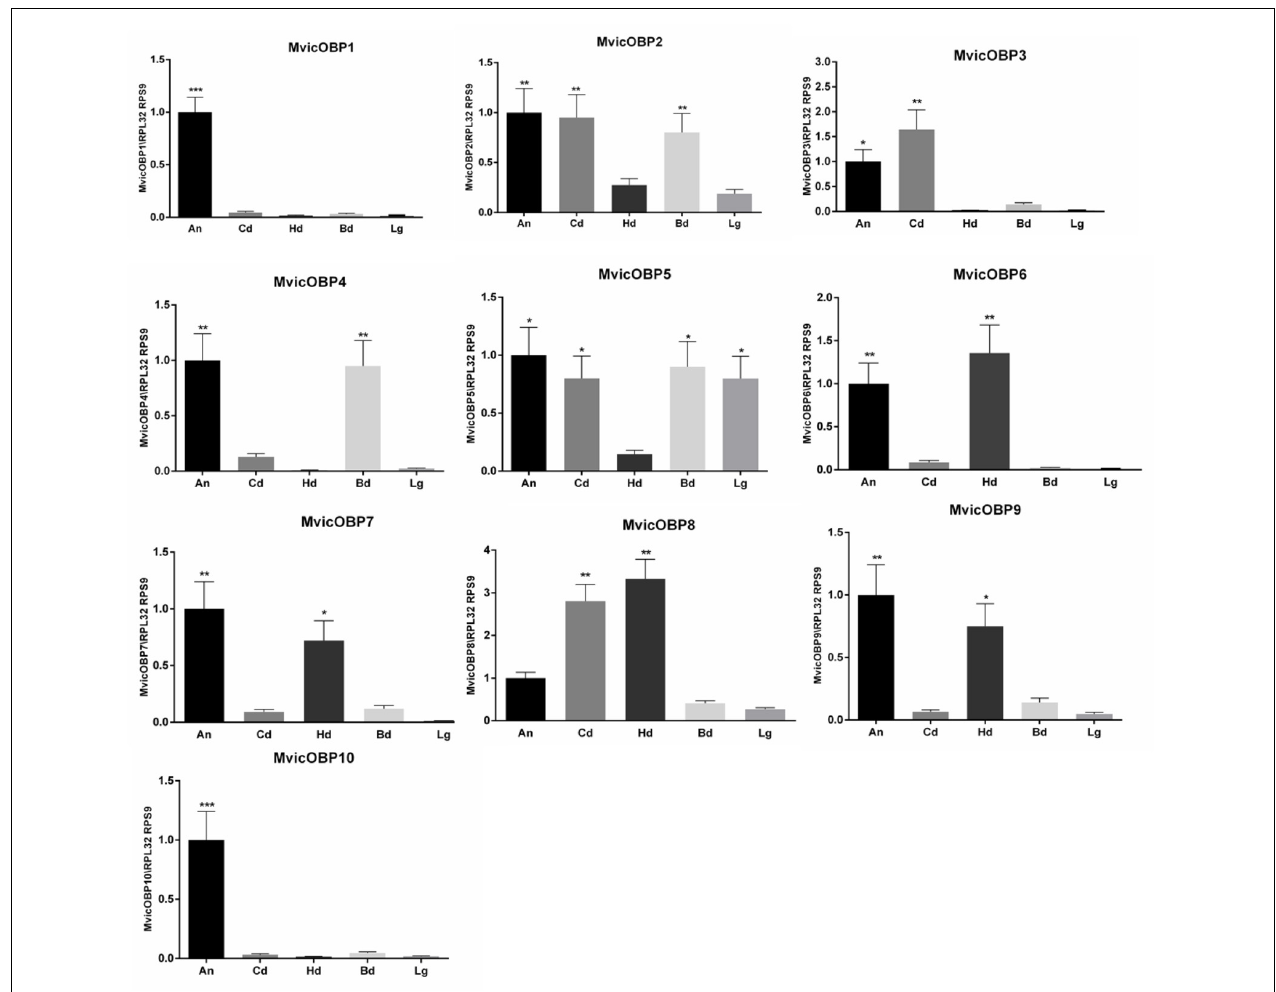
FIGURE 3 | Relative expression level of M. viciae OBPs in different body parts. OBP expression levels were quantified by RT-qPCR. Bars represent the standard deviation of the mean for 3 independent experiments. Significant differences are denoted by asterisks (Tukey’s test, ( ∗ p < 0.05, ∗∗ p < 0.01, ∗∗∗ p < 0.001)). Lg, legs; Cd, cornicles-cauda; Hd, head; Bd, body; An, antennae. Reference genes: RPL32 , RPS9 . Calibrator sample: